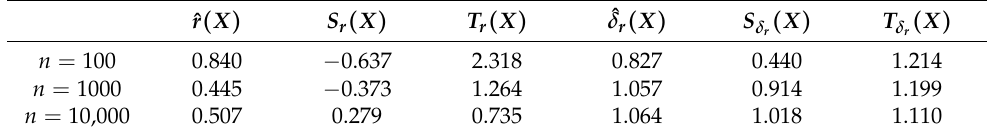
Table 3. Values of the estimates of the parameters r and δ with the corresponding asymptotic confidence intervals for the true values of the parameters r = 0.5, ν = 0.7, s = 1.5, t = 0.6, δ = 1.